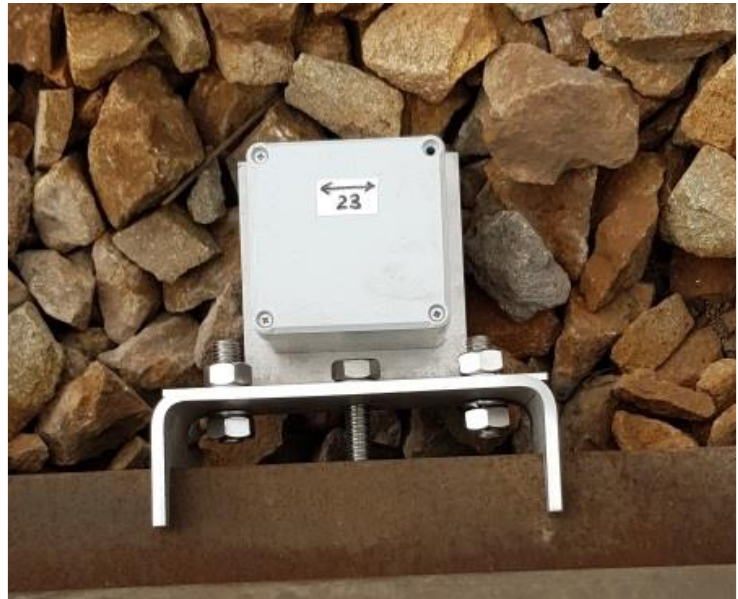
Figure 5. Sensor prototype mounted on rail.